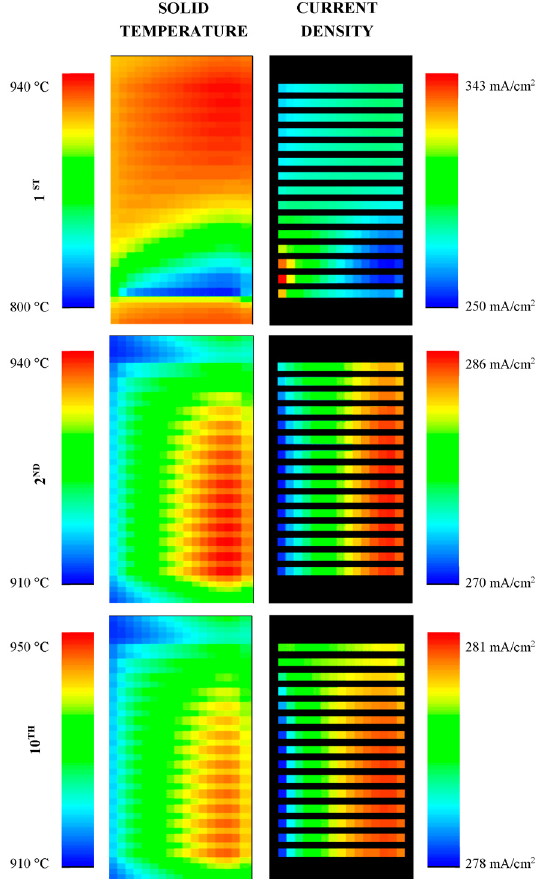
Figure 8. 2D distribution of solid temperature and current density (for the first, second and 10 th tube of the bundle).